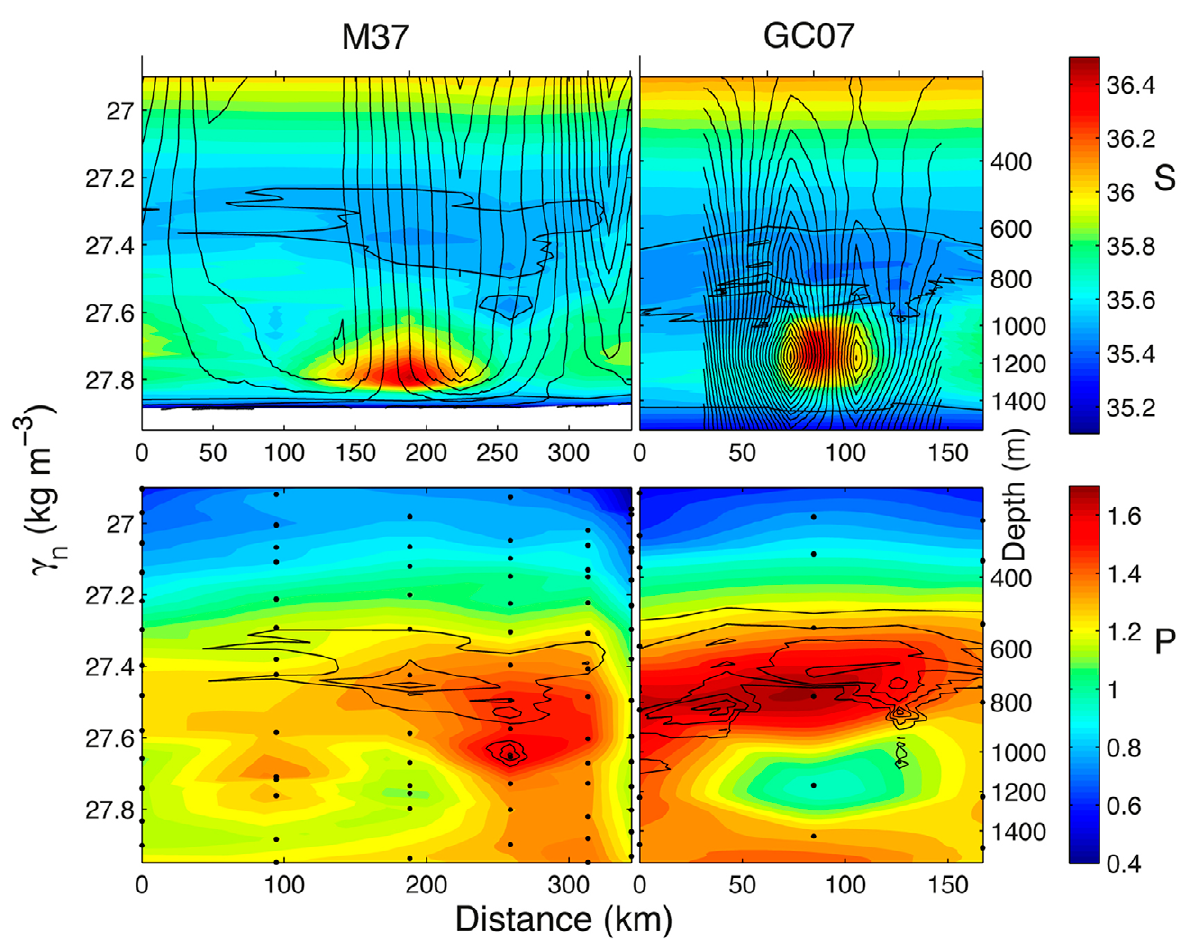
Fig. 7. – Salinity (upper panels) and phosphate (µmol kg −1 , lower panels) distributions as a function of neutral density and horizontal distance along the two hydrographic sections that sampled meddies M37 (left panel) and GC07 (right panel) (see their locations in Fig. 1); approximate depths are indicated on the right-hand axis. The contours represent the geostrophic velocity (cm s −1 , upper panels) and the AAIW contribution (%, lower